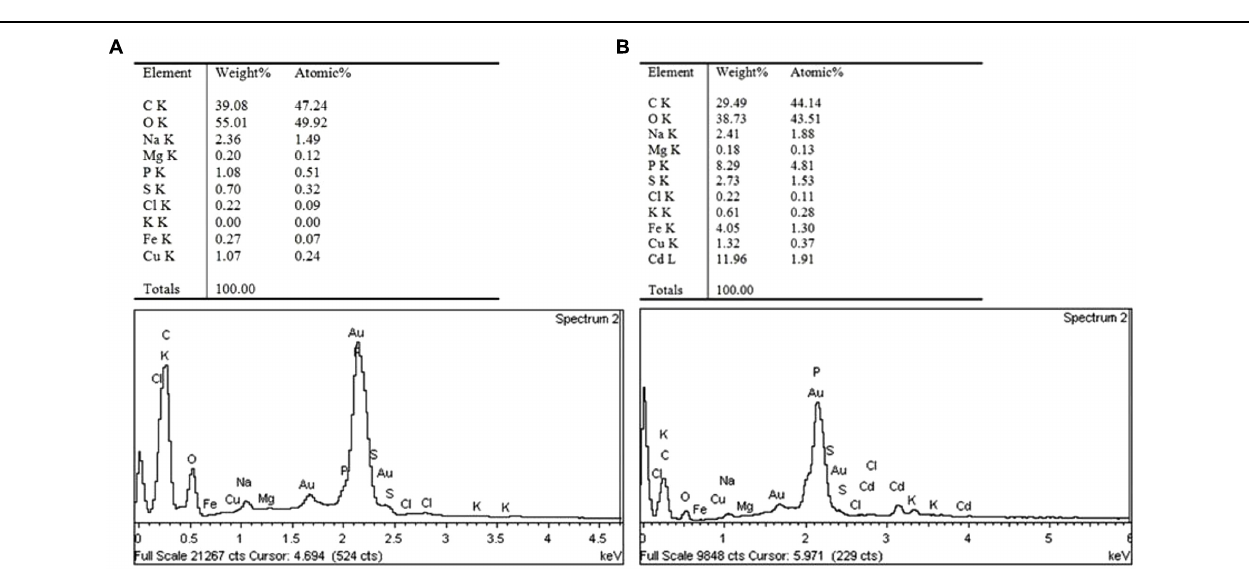
FIGURE 4 | The elemental contents of mycelia under (A) 0 mg Cd L − 1 and (B) 100 mg Cd L − 1 treatments.